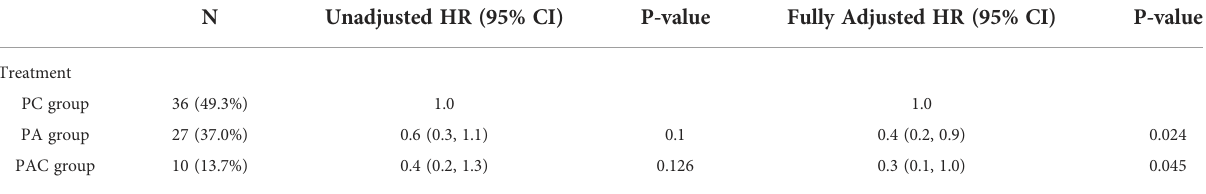
TABLE 5 Unadjusted and adjusted cox proportional hazards model for death.